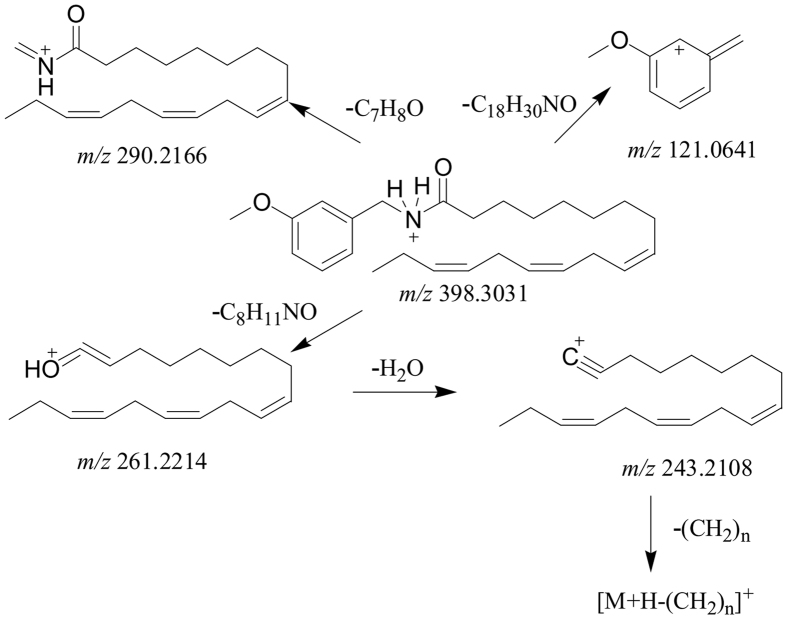
The fragmentation patterns of N-(3-methoxybenzyl)-(9Z, 12Z, 15Z)-octadecatrienamide (No. A32).